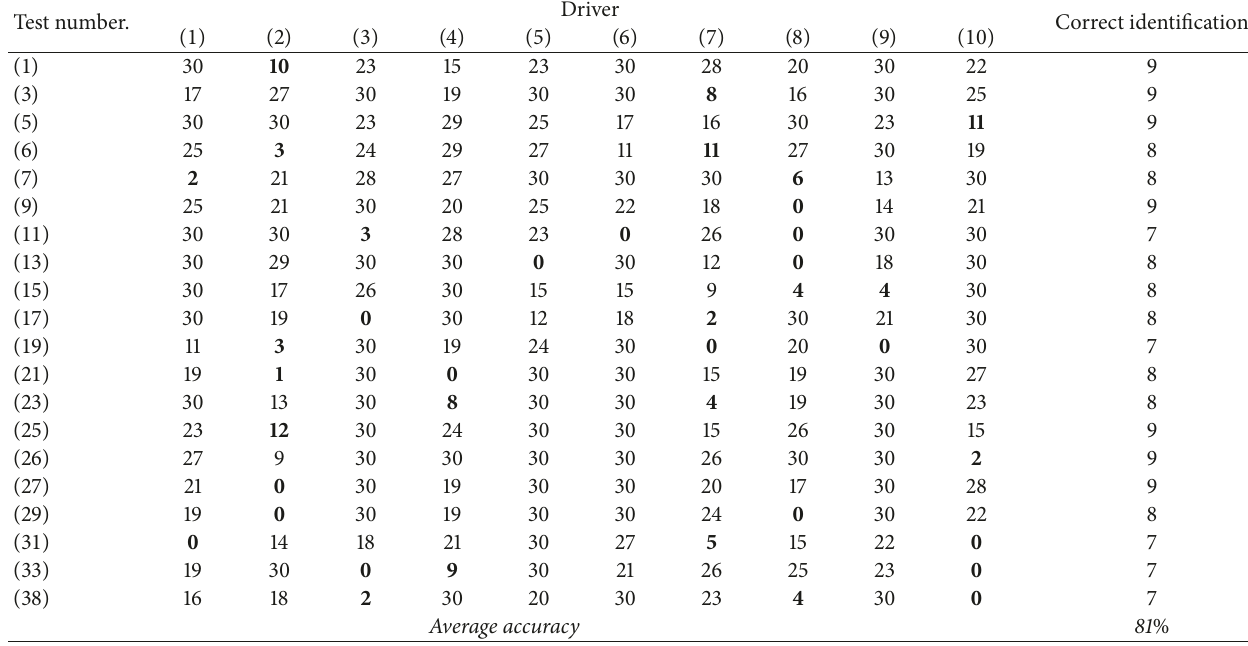
Table 5: The number in each cell indicates the number of input rows, out of total 30 in the testing window, that result in correct identification. The cells in bold are incorrect identifications, that is, the window where the number of correct identification is not the highest number. Test number.